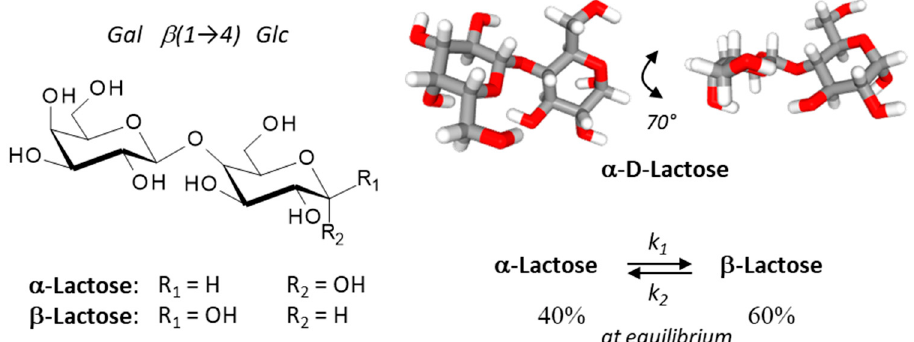
Figure 1. Structures of the two lactose anomers, α -lactose and β -lactose. Lactose contains a β -D- galactose unit linked to an α or a β -D-glucose unit through a β (1 → 4) bond. α -Lactose presents two crystalline forms, anhydrous α -lactose (C 12 H 22 O 11 ) and α -lactose monohydrate (C 12 H 22 O 11 • H 2 O). The stability of lactose in aqueous solution has been determined [22]. An overall lactose epimerization rate constant (k) of 4.4 × 10 − 4 s − 1 was measured at 25 ◦ C (forward rate constant k 1 of 2.5 × 10 − 4 s − 1 , and a reverse rate constant k 2 of 1.5 ×10 − 4 s − 1 ; K = 1.6 ±0.1) and the half-life (t 1/2 ) was 28.3 min at 25 °C. At equilibrium, the α / β anomeric ratio of lactose samples was about 39–41/59–61%, as determined at 25°, 45° and 60 °C.